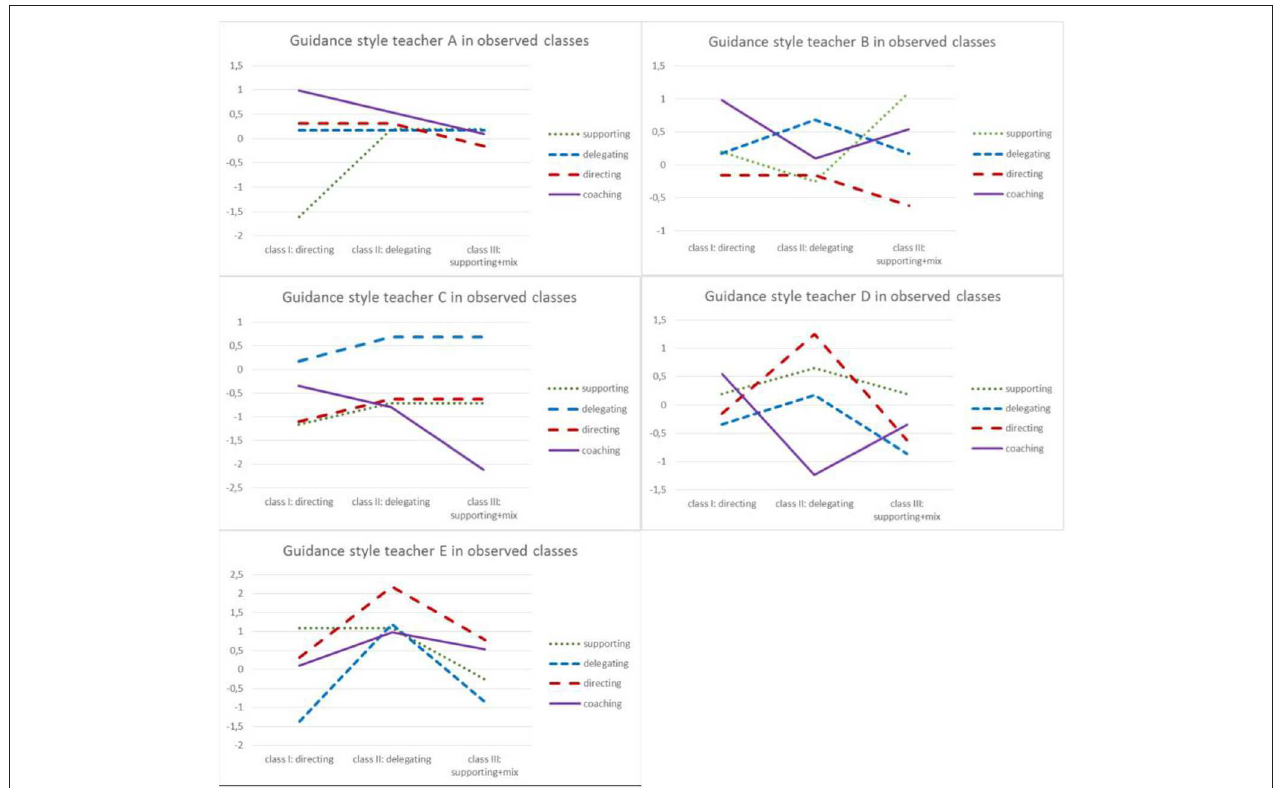
FIGURE 5 | The guidance style of the observed teachers. This figure shows that, for example, teacher A uses a mix of styles in all classes (supporting is less used in class I) and that teacher C uses the delegating style most in all classes.